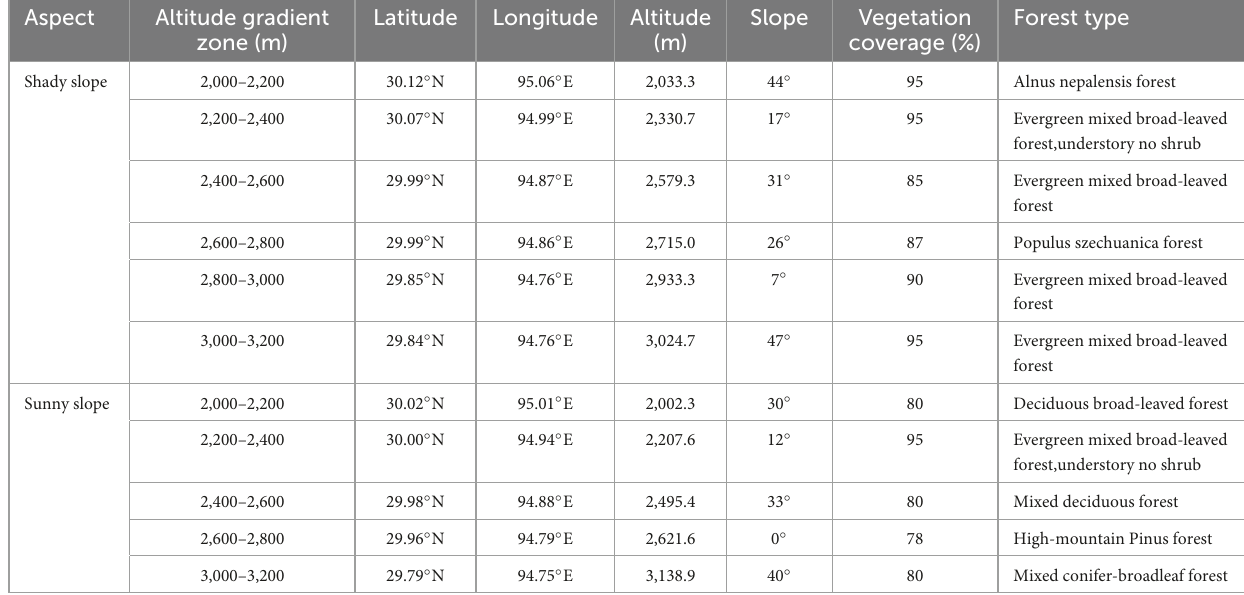
TABLE 1 Basic information of the research sites.